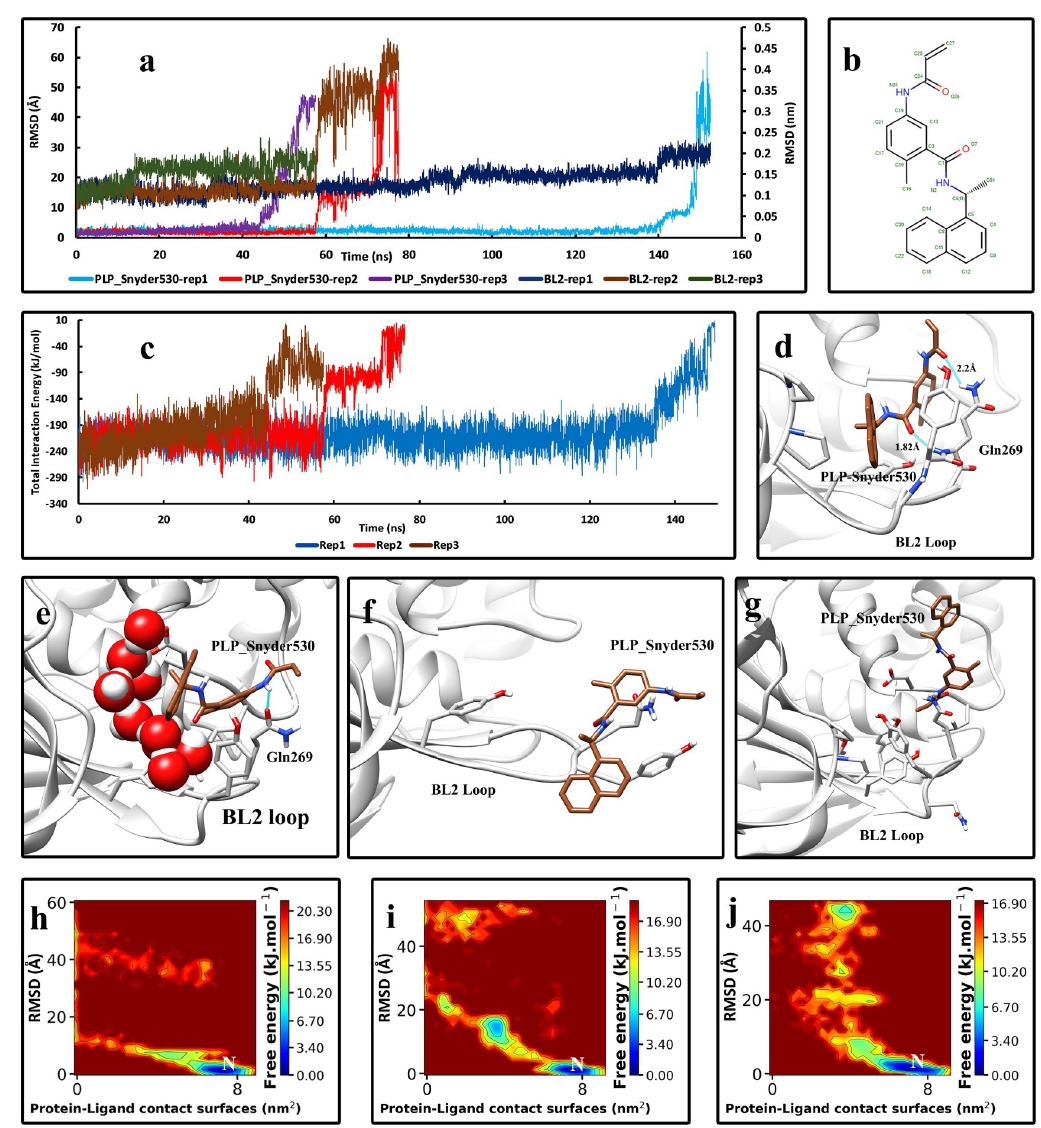
Fig 5. The details of the unbinding pathway of PLP_Snyder530 from SARS-CoV-2 Plpro in three series of replicas. (A) The RMSD values of the inhibitor in three replicas (Displayed in Å ) and the backbone RMSD values of residues of the BL2 loop in three replicas (Displayed in nm) throughout the simulations. (B) The 2D structure of PLP_Snyder530 was obtained from PDB. (C) The Total interaction Energies of the protein-ligand complexes throughout the simulations. (D) The bound state of the PLP_Snyder530 in the crystallographic (native) conformation and the interactions with the residues of the binding pocket (frame at 0 ns). (E) An intermediate state of PLP_Snyder530 in the unbinding pathway in which the naphthalene moiety had turned and is out of the crystallographic (native) binding conformation (3rd replica, frame in 50 ns). (F) Another intermediate state where the BL2 loop is completely flat and the inhibitor is stuck to the residues on the tip of the loop (Tyr268 and the Gln269) (2 nd replica, frame in 60 ns). (G) The unbound state of the inhibitor that is completely free and solvated in the simulation box. (H) The free energy landscape (FEL) representation of the unbinding pathway of the PLP_Snyder530, replica No 1. (I) The free energy landscape (FEL) representation of the unbinding pathway of the PLP_Snyder530 replica No 2. (J) The free energy landscape (FEL) representation of the unbinding pathway of the PLP_Snyder530, replica No 3. Letter “N” indicates the native crystallographic